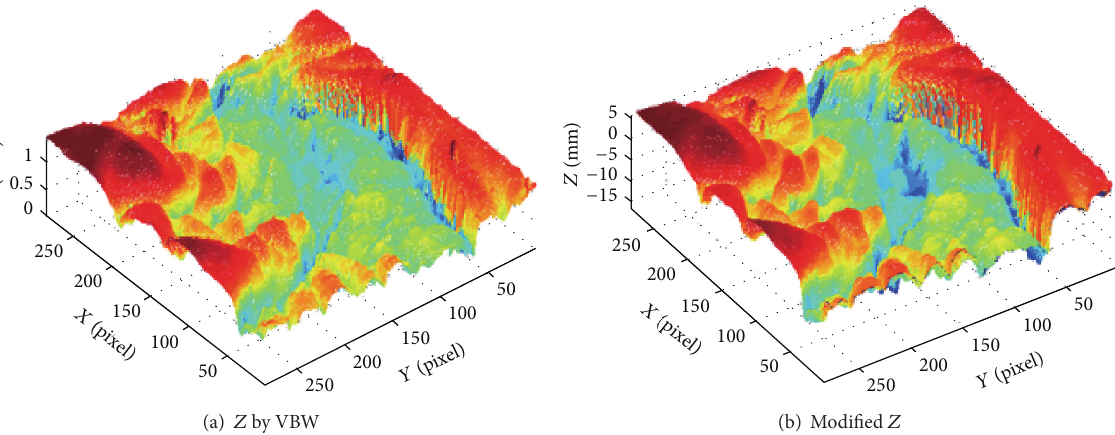
Figure 15: Result for endoscope images.